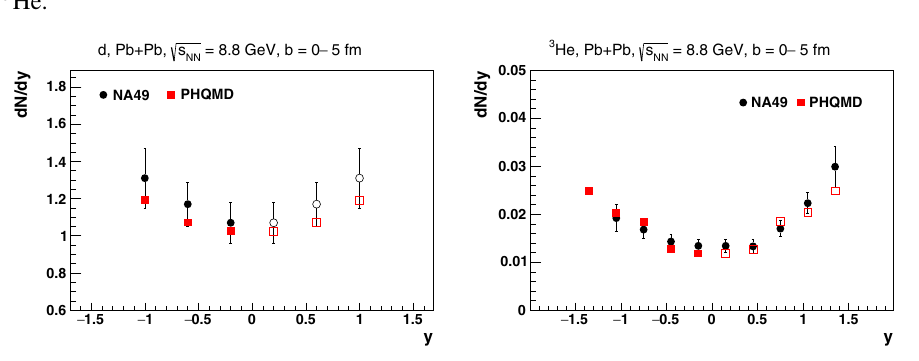
Figure 1. The rapidity distribution of deuterons (left) and 3 He (right) for central Pb + Pb collisions at the beam energy E kin = 40 A GeV. The dots indicate the experimental data from the NA49 Collaboration [3]; the red squares show the PHQMD results taken at the physical time t = t 0 cosh( y ) for t 0 = 53 fm / c for deuterons and for t 0 = 67 fm / c for 3 He. The figure is taken from Ref. [7].